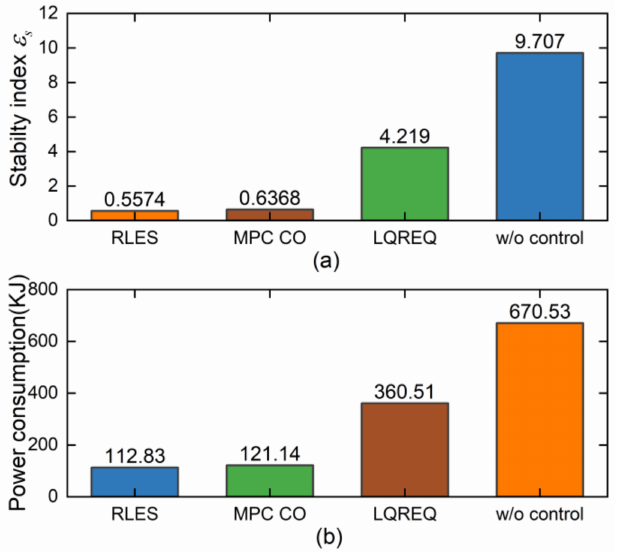
Figure 11. Simulation results under joint road. ( a ) Stability index ε s ; ( b ) motor power consumption.